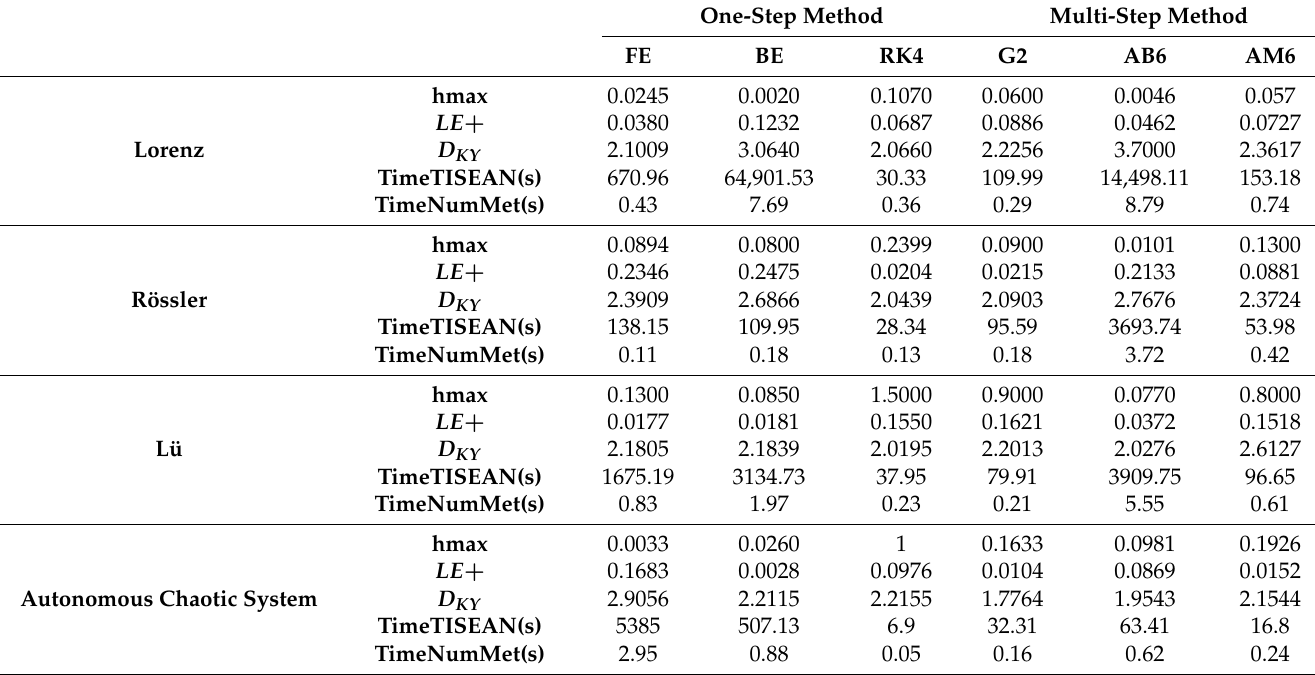
Table 5. LE + and D KY of (1)–(5) using the highest h allowed by each numerical